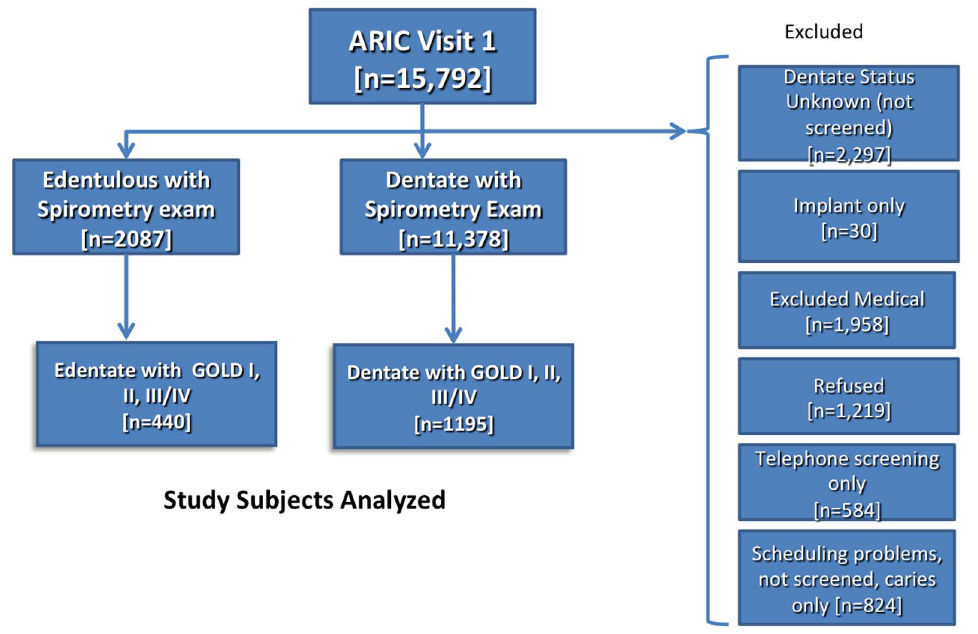
Figure 1. Study Subjects Analyzed. doi:10.1371/journal.pone.0068592.g001 PLOS ONE |